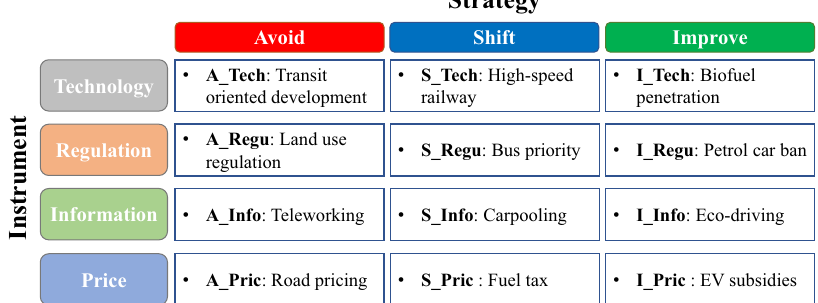
Fig. 1 A-S-I matrix and policy examples. Each strategy in the A-S-I matrix includes technological, regulatory, informatic, and price instruments.